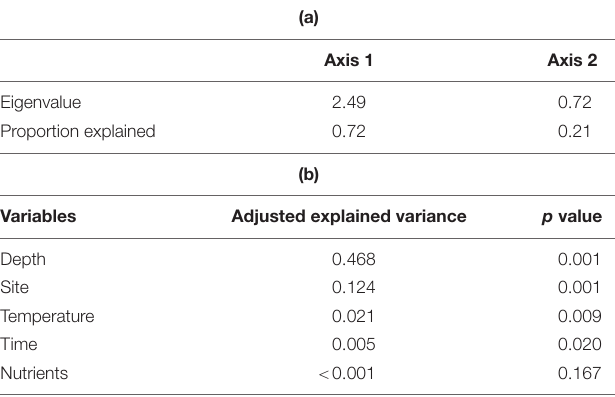
TABLE 2 | Results of redundancy analysis (dbRDA) showing (a) the eigenvalues and percentage of the overall variance explained by the first two axes, and (b) the relative contribution to constrained variance of tested